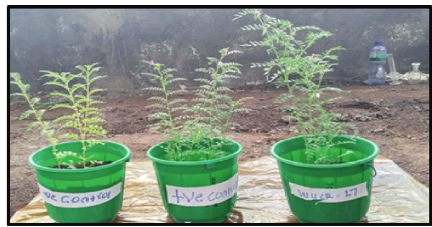
Figure 3: Effect of rhizobia on shoot growth. Table 2: Pearson correlation coefficient comparisons for nodule number, nodule dry weight, shoot dry weight, shoots length, and symbiotic